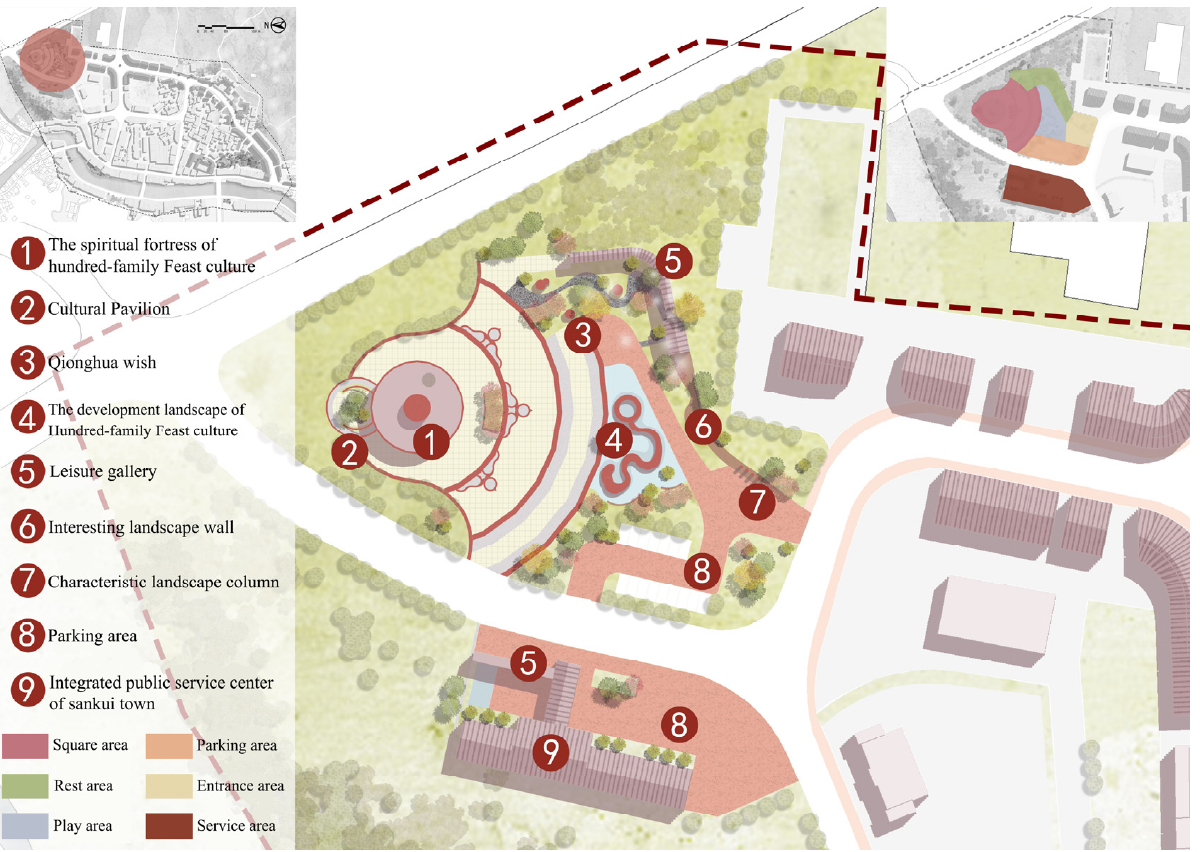
Figure 8. The plan of Hundred-family Feast cultural entrance experience zone landscape. There are two landscape element carriers presented in this zone, namely, the spiritual fortress of hundred-family Feast culture and the development landscape of the Hundred- family Feast culture (Table 3). The overall shape of the spirit fortress is extracted from the shape and working principle of the Qionghua pyrotechnic puppet, one of the puppets in Taishun County. It is a visual representation of the spirit of the Hundred-family Feast culture. The Qionghua puppet is rotated by the power of firecrackers, while the spirit fortress is rotated on each level by the wind. The storyline of the development of the Taishun Hundred-family Feast culture is presented through a long, curved waterfall with three levels flowing from each level to the next. The Hundred-family Feast Cultural Square as the spatial carrier is divided into an entrance area, a square area, a rest area, a play area and a parking area (Table 3). The main entrance is opposite to the public service centre, and the secondary entrance is connected to the car park. The integrated public service centre including indoor spaces and outdoor resting spaces is a key step for improving the